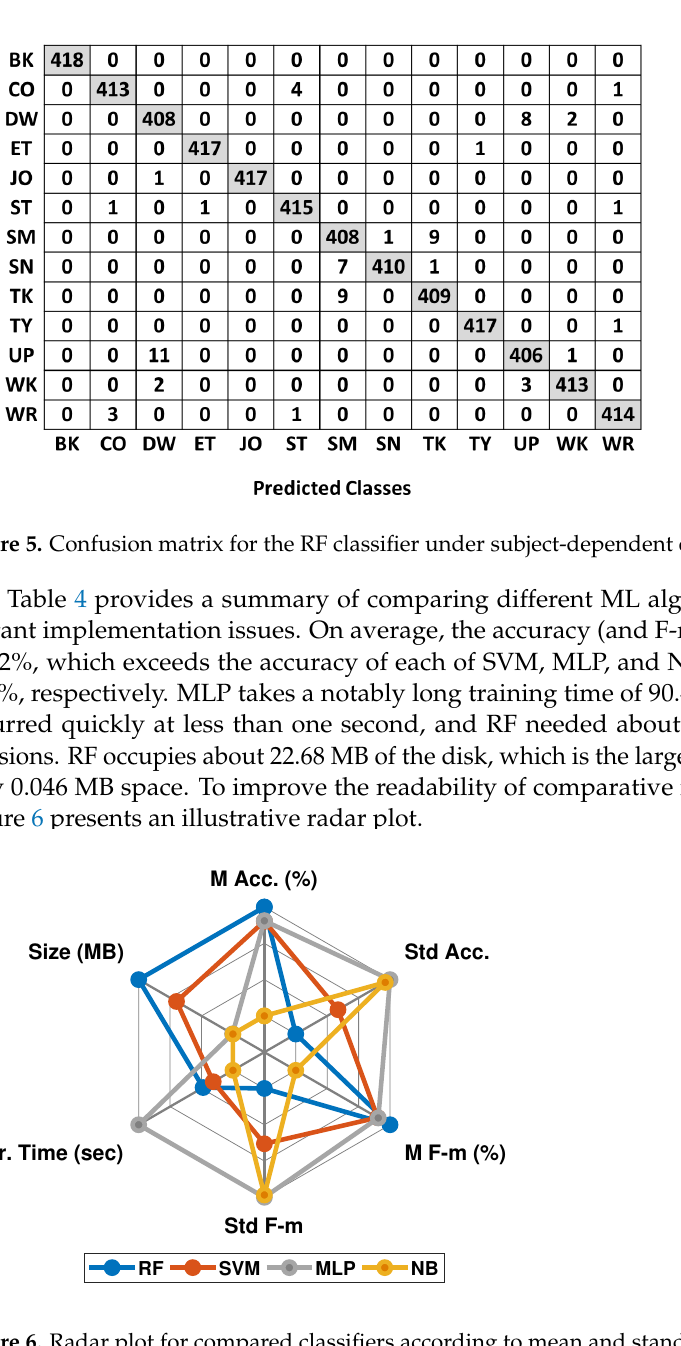
Figure 6. Radar plot for compared classifiers according to mean and standard deviation of accuracy (M Acc (%)) and (Std Acc), respectively; mean and standard deviation of F-measure (M F-m (%)) and (Std F-m), respectively; raining time in sec. (Tr. Time (sec)); and Size on disk in MB (Size